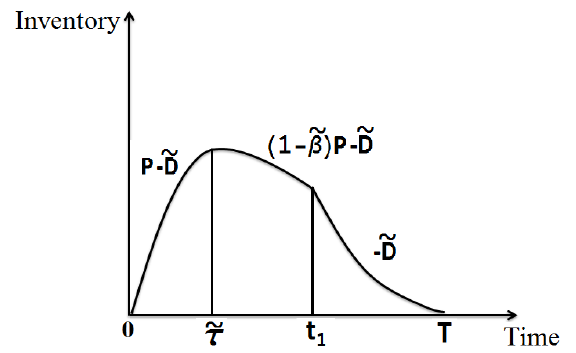
Figure 1. Pictorial representation of the manufacturer’s inventory of a perfect-quality